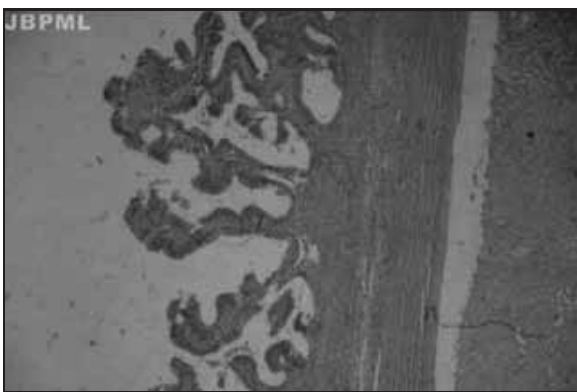
Figura 4 – Aspectos imunofenotípicos (streptoavidina-biotina-peroxidaseimagem 1): expressão de citoceratina 7 em túbulos